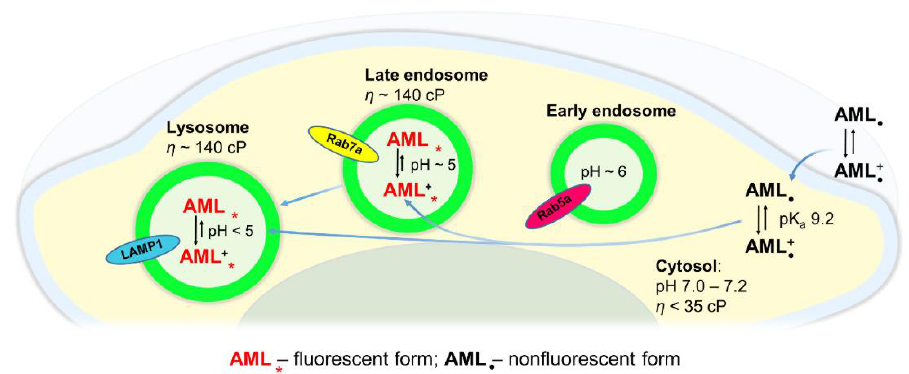
Figure 7. Proposed mechanism of AML interactions with cellular vesicles. AML penetrates the plasma membrane and accumulates in acidic compartments giving the fluorescence enhancement in the viscous medium. Protonated AML molecules are trapped in the late endo-/lysosomal vesi-